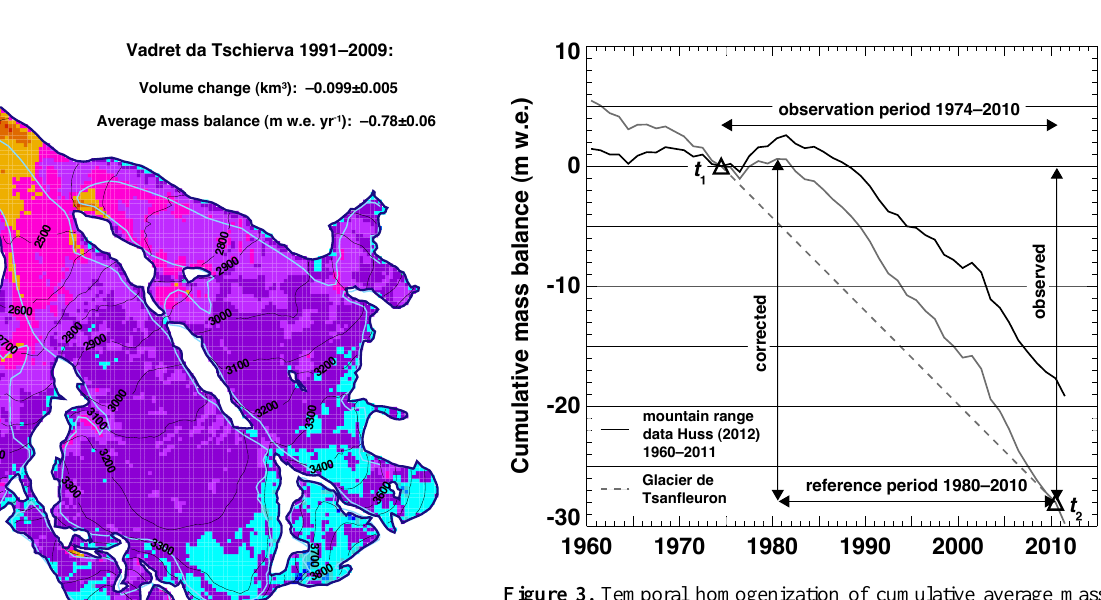
Figure 3. Temporal homogenization of cumulative average mass balance from DEM differencing for Glacier de Tsanfleuron (dark grey) based on cumulative mean annual mountain-range mass bal- ance from Huss